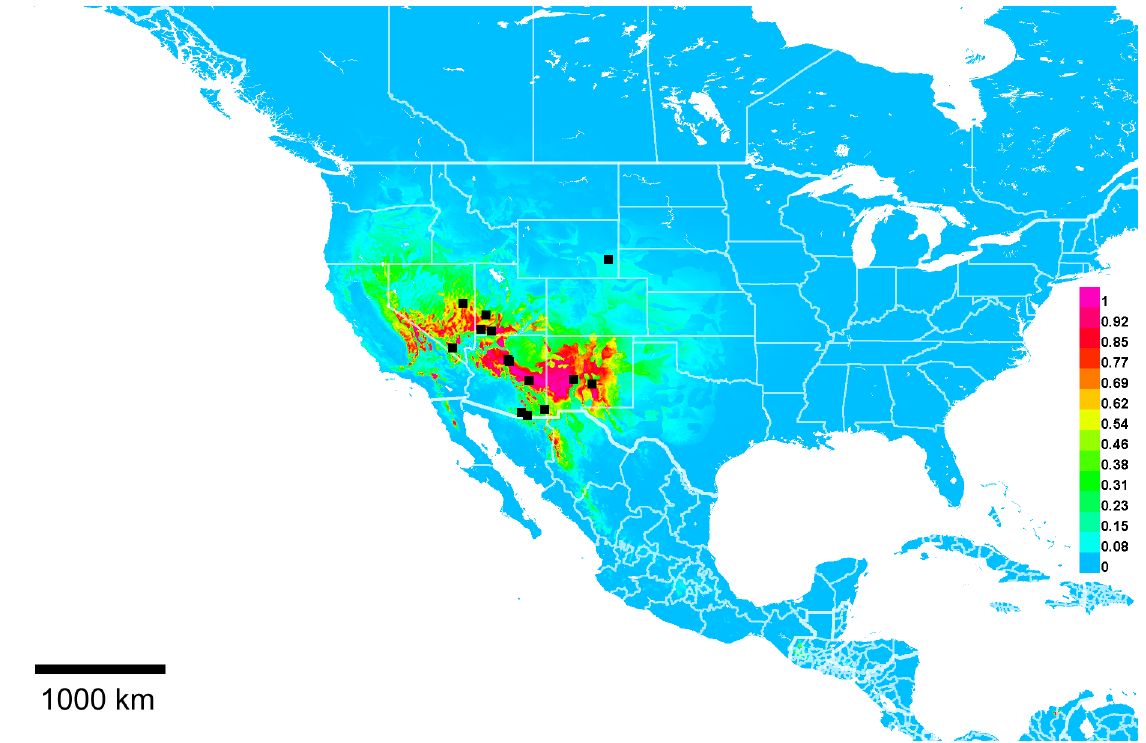
Fig. 23. Georeferenced collection records of Lasioglossum ( D .) eremum sp. nov. (black squares) and predicted distribution by maximum entropy ecological niche modelling in Maxent (colour shading). Warmer colours indicate higher cloglog probability of